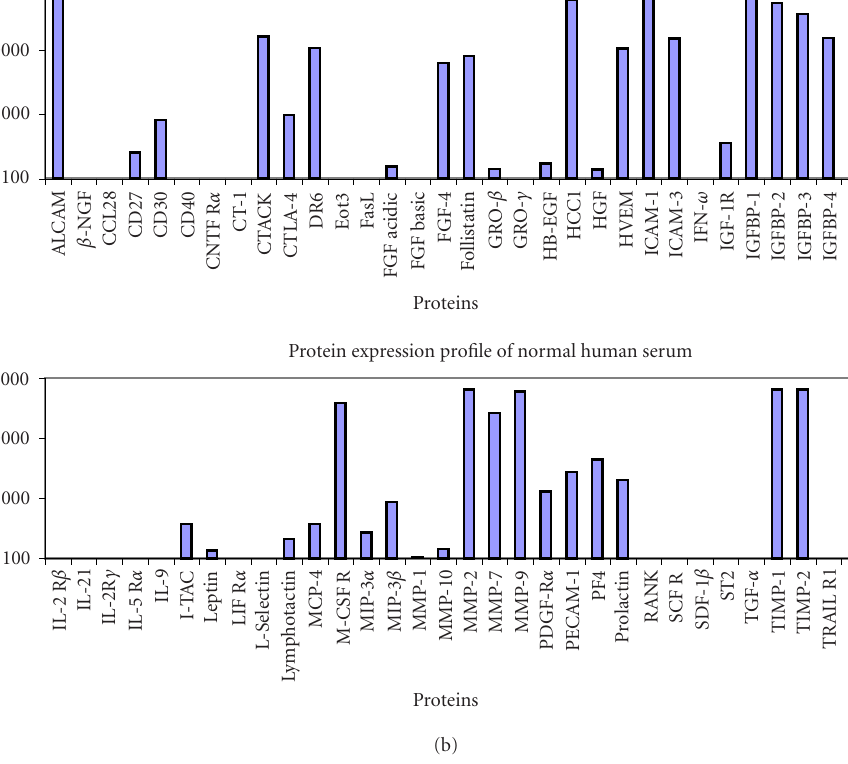
Figure 5. Protein expression profiling of normal human serum (Sigma) on 70-feature antibody microarray. Specific signals detected were consistent with the protein level in serum. (a) Images of detecting 70 proteins in antibody microarray obtained with Axon microarray scanner. (b) Fluorescence intensities were derived from microarray images with averaging four spots of the same feature.